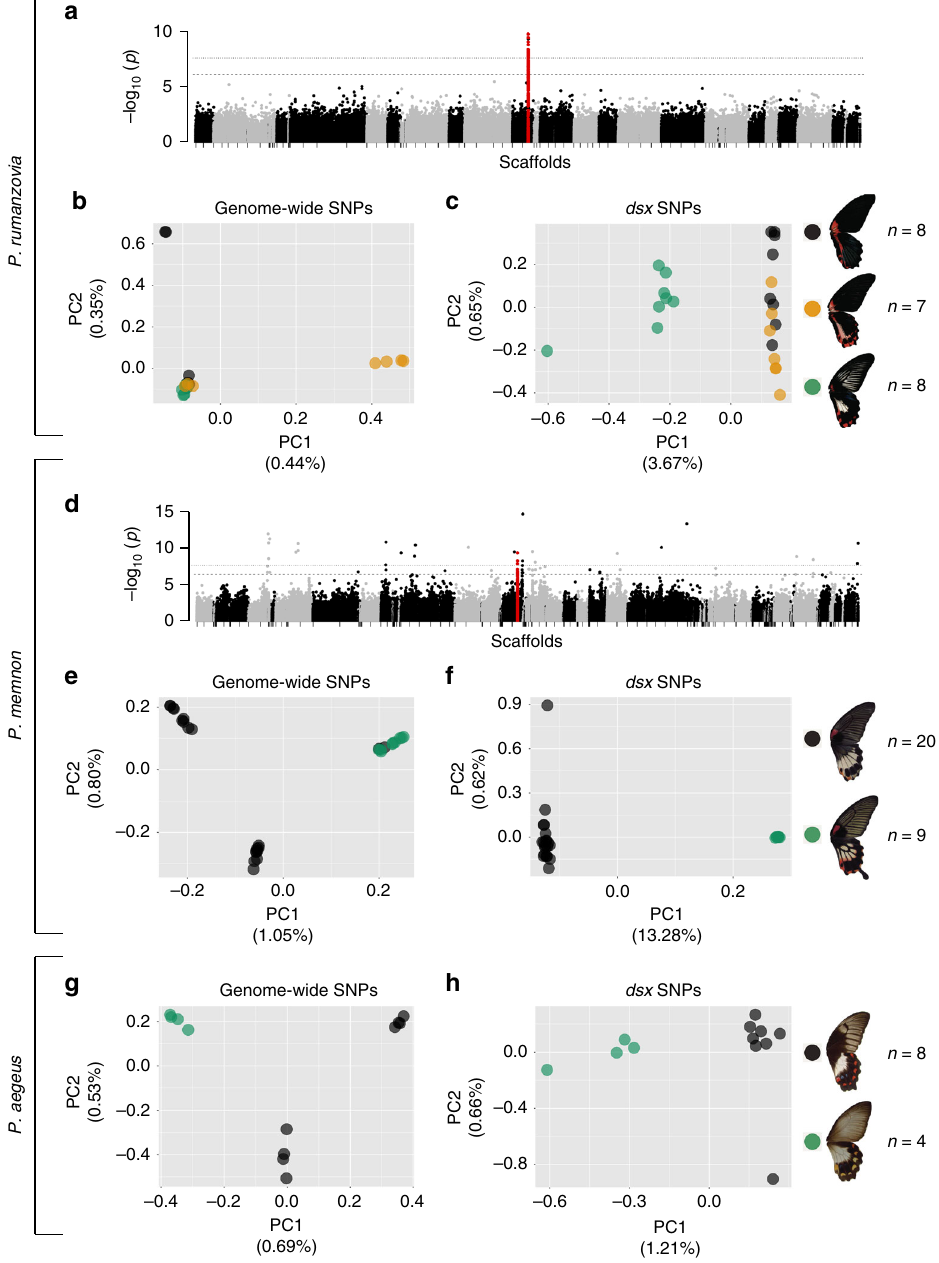
Fig. 2 Identifying mimicry loci in P. rumanzovia , P. memnon , and P. aegeus . Genome-wide association study (GWAS) for wing patterning in P. rumanzovia ( a ) and P. memnon ( d ). Principal component analysis (PCA) based on genome-wide variants for P. rumanzovia ( b ), P. memnon ( e ), and P. aegeus ( g ). PCA based on dsx variants for P. rumanzovia ( c ), P. memnon ( f ), and P. aegeus ( h ). Red points in a and d indicate SNPs in the dsx region. Dashed and dotted lines in a and d show the false discovery rate ( q -value) cutoffs of 0.01 and 0.001,